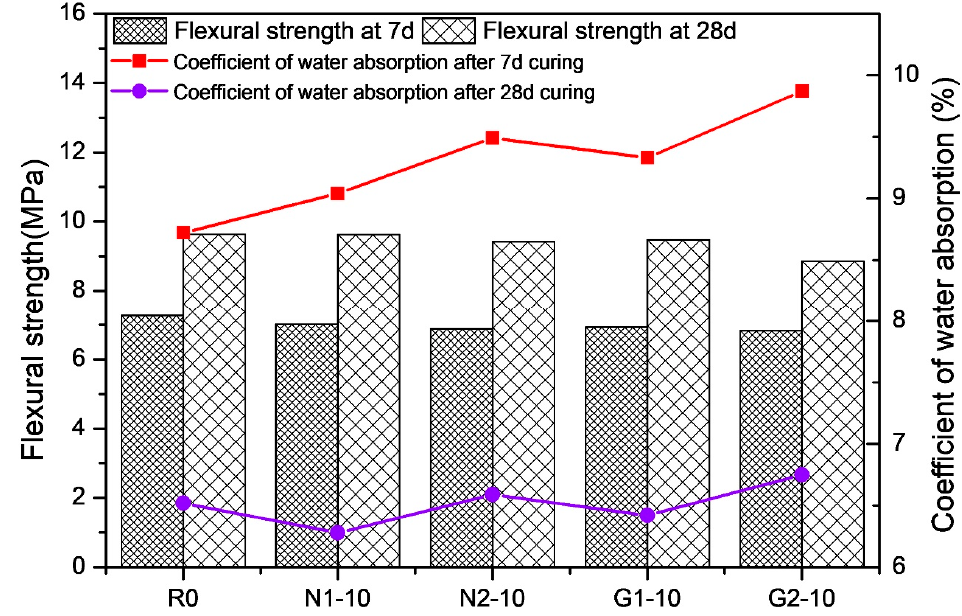
Figure 6. Flexural strength and coefficient water absorption of different types of RHA-cements at 7 and 28 d.